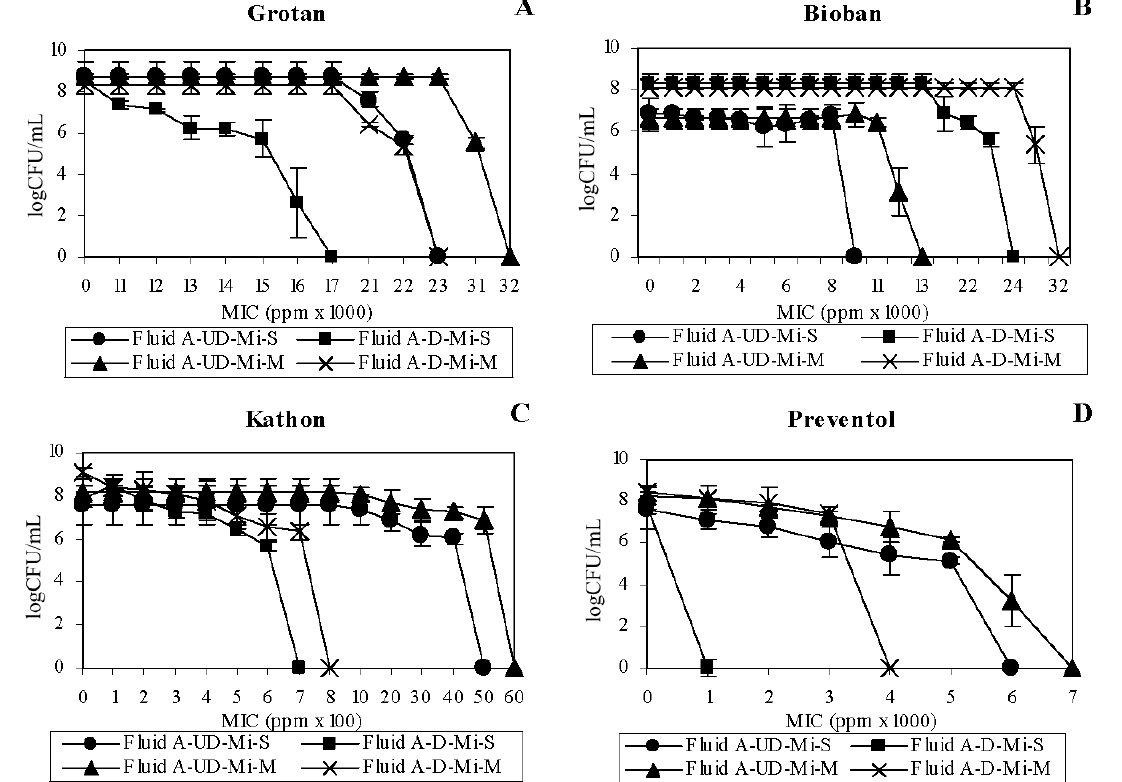
Figure 3. Effect of fluid dialysis on biocidal efficacy toward M. immunogenum . Undialyzed and dialyzed forms of Fluid A were used to compare the biocidal activity of four individual test biocides namely, Grotan (Panel A ), Bioban (Panel B ), Kathon (Panel C ) and Preventol (Panel D ) in terms of minimum inhibitory concentration (MIC), either in single culture (pure) suspension or in mixed culture suspension (1:1 ratio with P. fluorescens ) of M. immunogenum . The MIC values were based on 100% killing of the test organism and are means of the triplicates. The test organism was exposed to varying levels of the individual biocides for 60 min each in the two test MWF